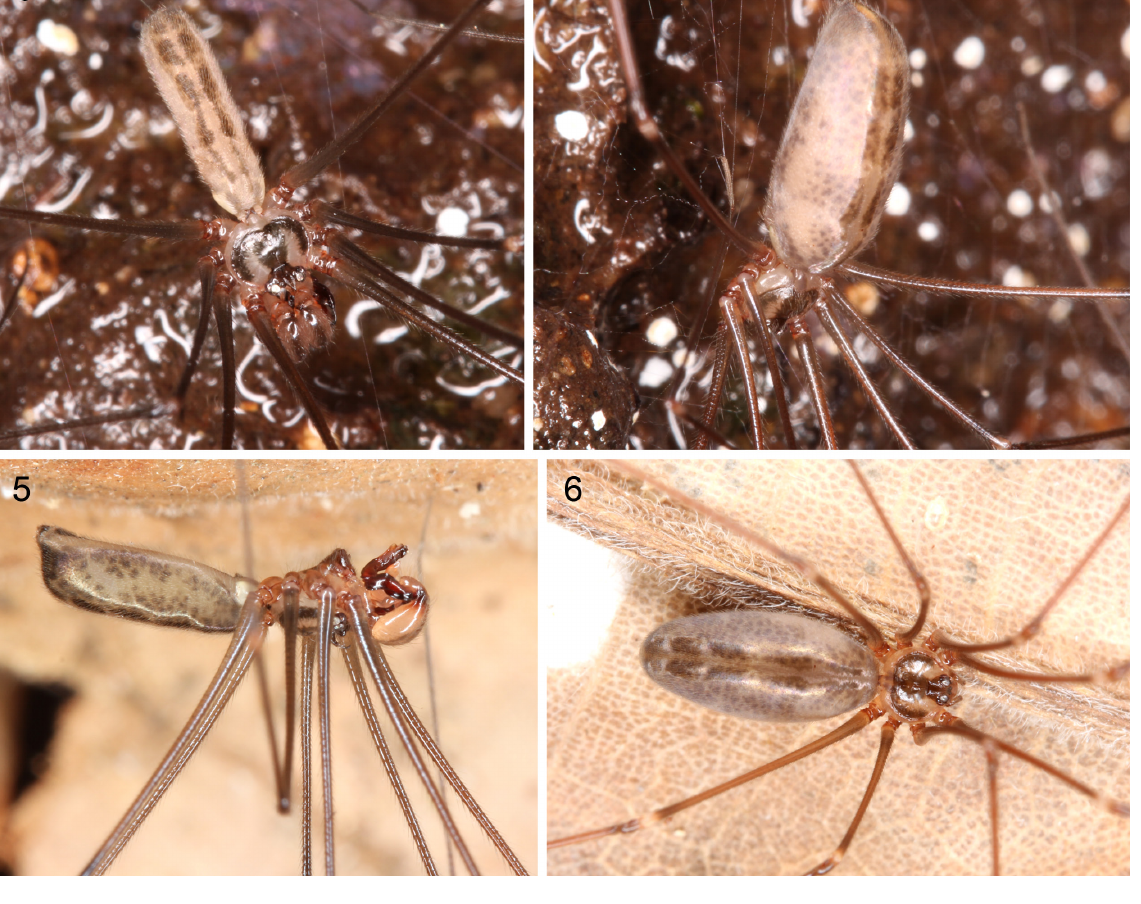
Figs 3–6. Live specimens, Pholcus olangapo Huber, sp. nov., Pamulaklakin Forest Trail. 3–4 . ♂ and ♀ in their natural habitat. 5–6 . ♂ and ♀ photographed on a dead